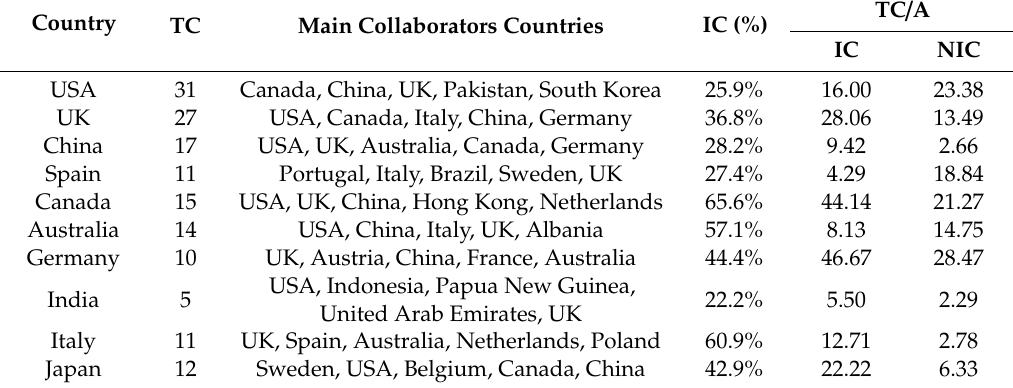
Table 8. The most productive countries and international collaboration